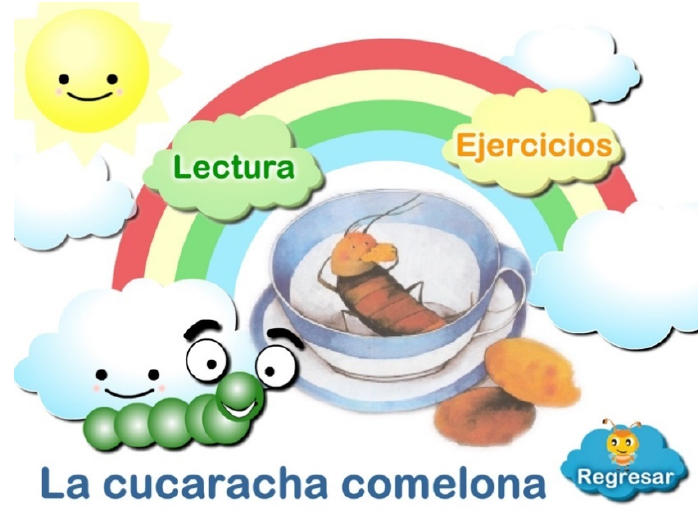
Figure 6. Options for each guided reading.